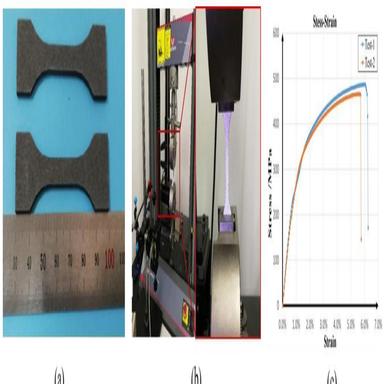
(a) AlSi10Mg specimens; (b) DIC device and tensile test machine; (c)strain-stress curve.